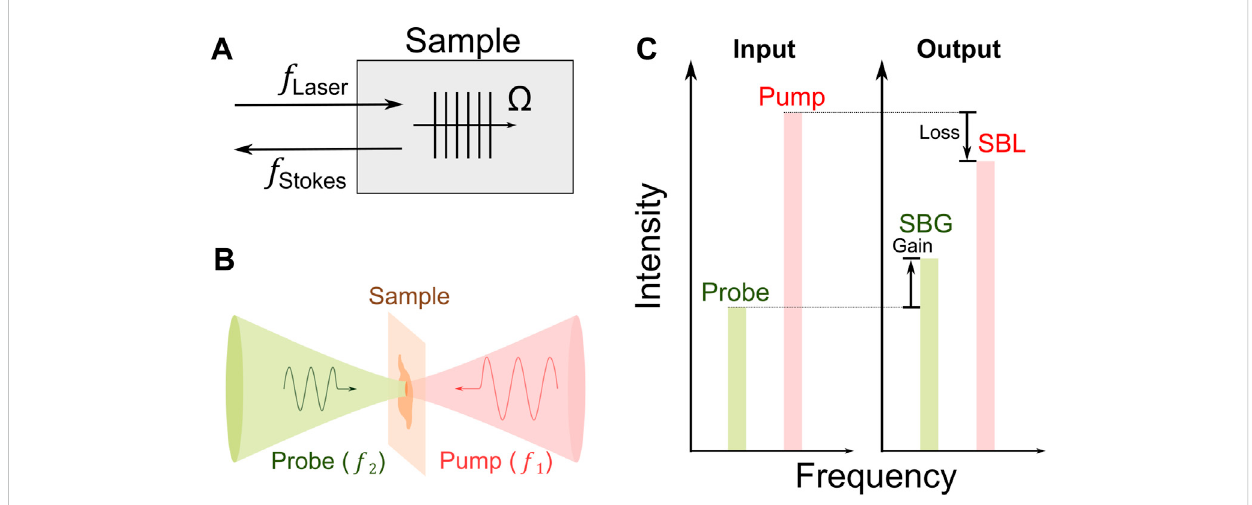
FIGURE 1 PrincipleofstimulatedBrillouinscattering. (A) SchematicofstimulatedBrillouinscatteringprocess. Ω :frequencyofacousticwave. (B) Schemeofcw SBS used for biomedicine. (C) Energy transfer between the pump and the probe. SBG: stimulated Brillouin gain; SBL: stimulated Brillouin loss.